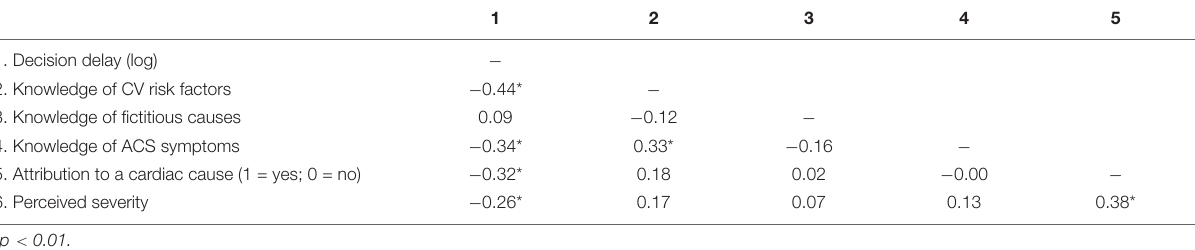
TABLE 4 | Pearson correlations between decision delay with the other variables of interest.